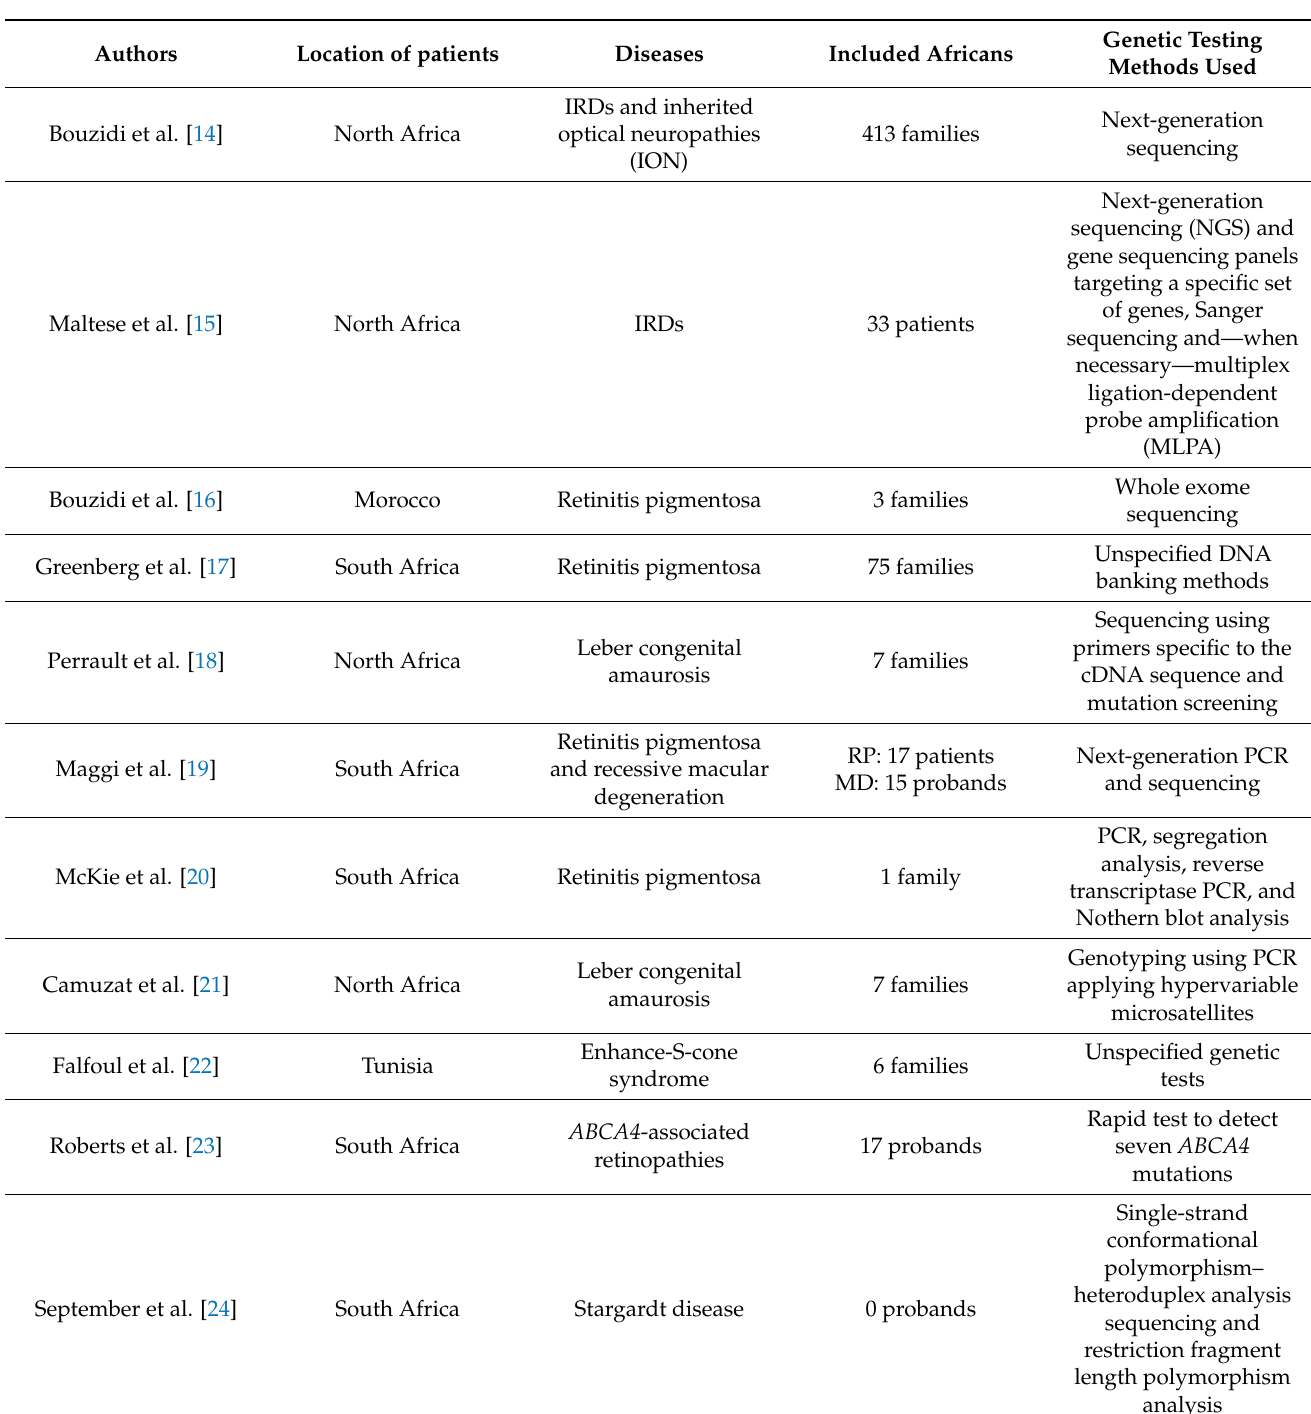
Table 1. Summary of studies addressing the topic of genetic testing of inherited retinal disorders (IRDs) among